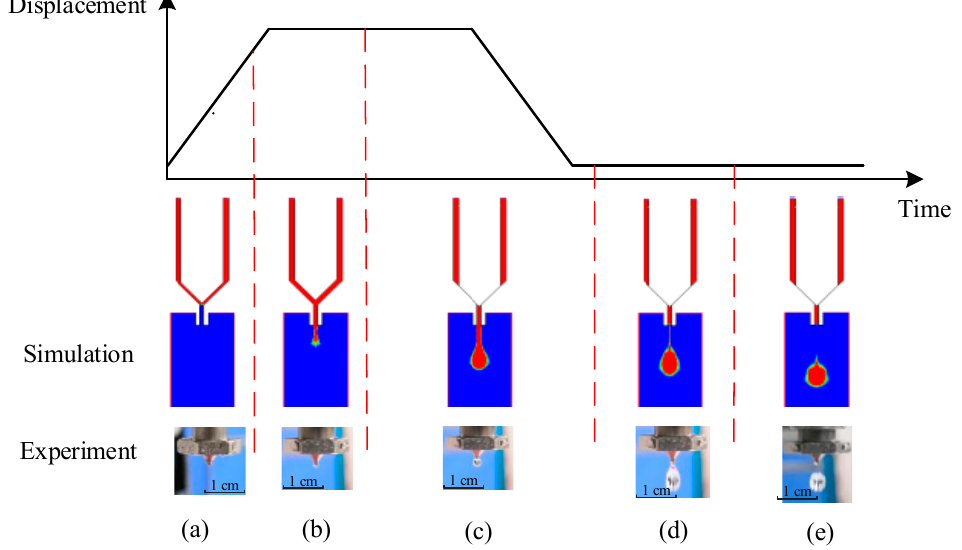
Figure 4. Morphological changes in the droplet in a jetting cycle: ( a ) Initial stage; ( b ) growth stage; ( c ) extension stage; ( d ) breakage stage; ( e ) separation stage.